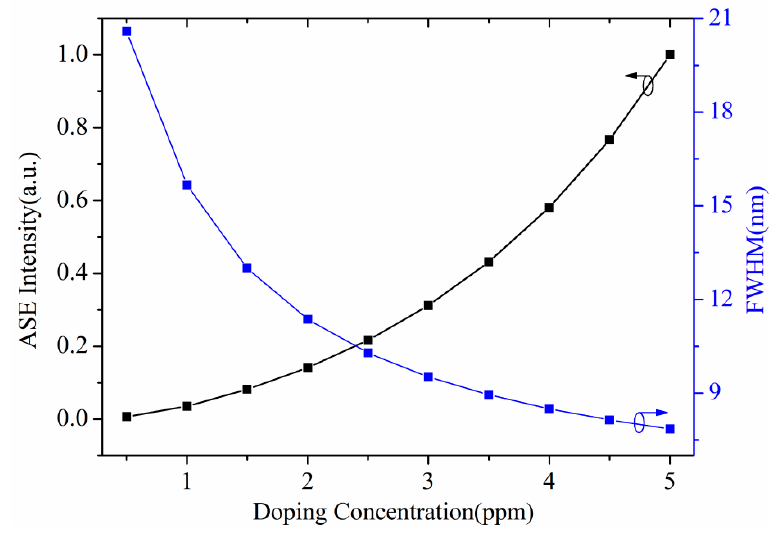
Figure 12. The output ASE intensity and FWHM as a function of the QDs doping concentrations.